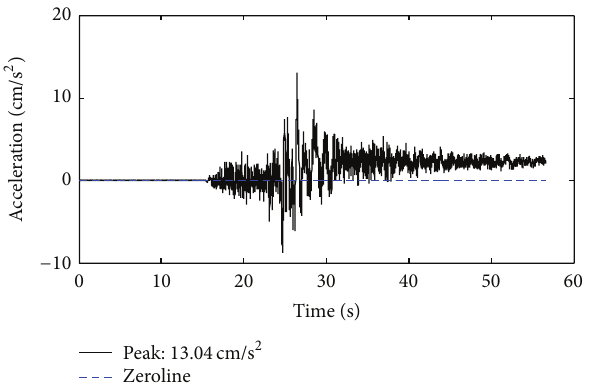
Figure 18: Acceleration time